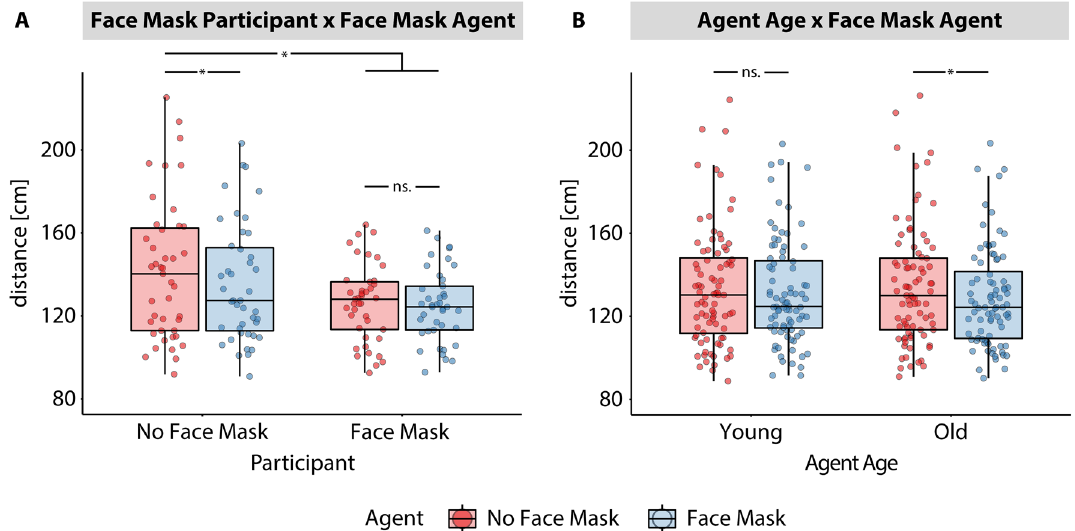
Figure 2. Step down analyses of significant interaction effects in the detour path trials. ( A ) Box plots show minimal distances as a function of “Face Mask Participant” and “Face Mask Agent”. ( B ) Box plots show minimal distances as a function of ”Agent Age” and “Face Mask